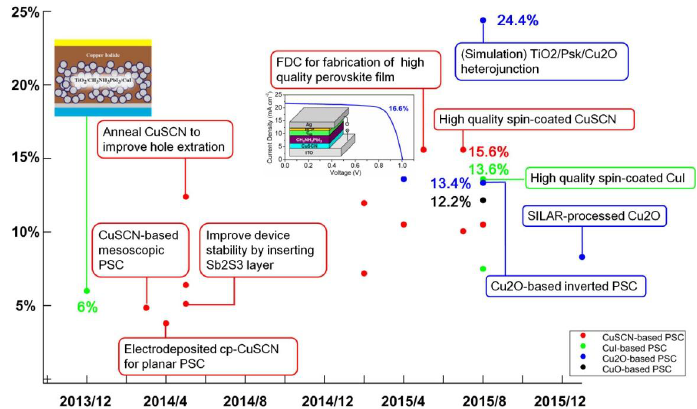
Figure 5. Power conversion efficiency (PCE) trends of CuSCN-, CuI, Cu 2 O-, CuO-based organometallic lead halide perovskite solar cell (PSC). cp, compact film; FDC, fast deposition-crystallization; Psk, perovskite; SILAR, successive ionic layer adsorption and reaction.